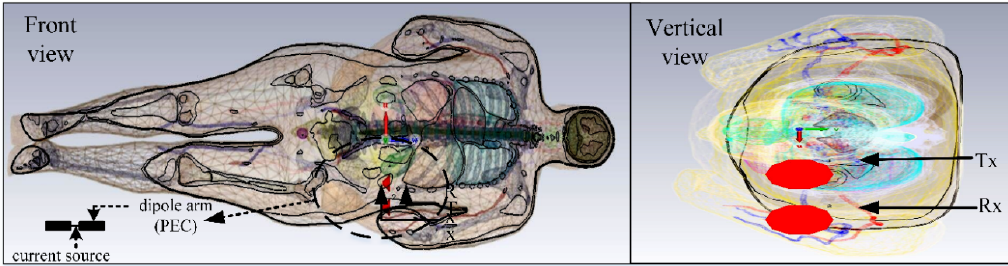
Figure 3. The 3D human body model and dipole antennas. (left ) front view; ( right ) vertical view. Table 1. Conductivity ( ε r ), Relative Permittivity σ and Loss Tangent tan δ [24]. Parameter Skin SAT BT Muscle